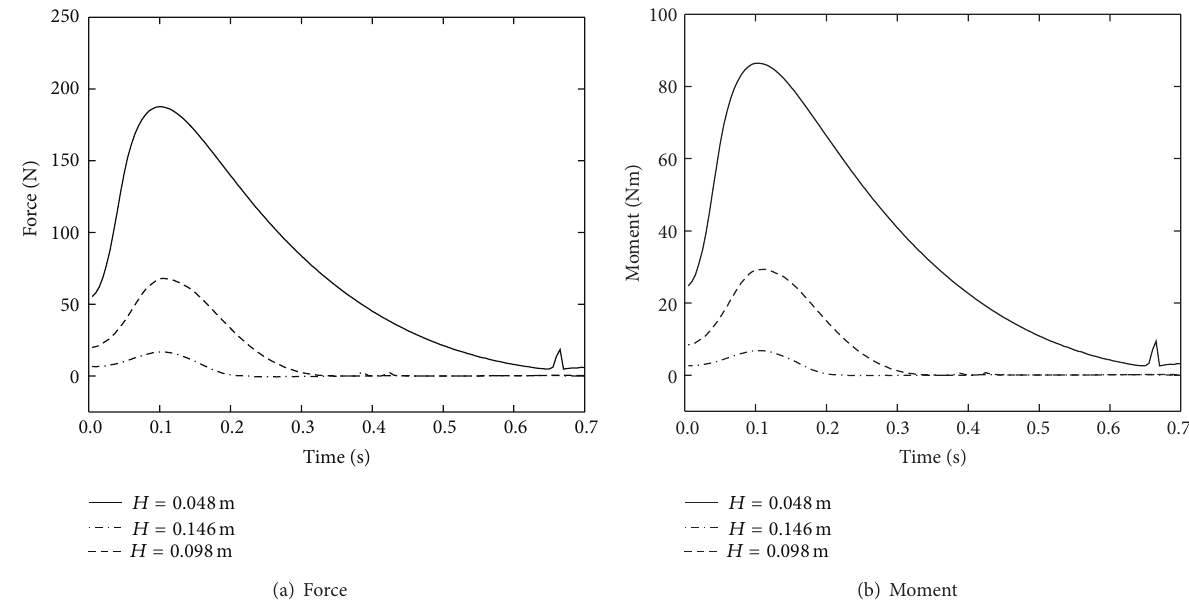
Figure 12: Pressure and moment of the